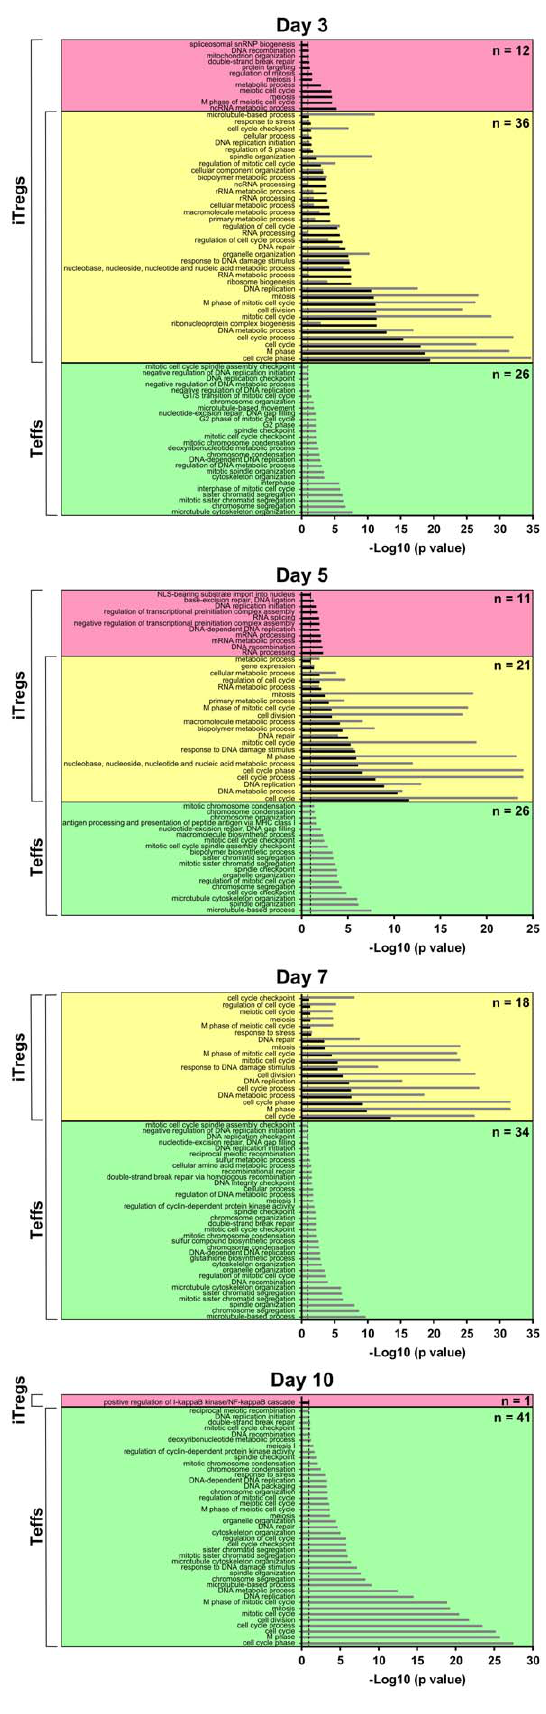
Figure 4. GO term enrichment analysis of biological processes in developing iTregs and Teffs. GO term analysis was performed to identify biological processes significantly over-represented in iTregs and Teffs. Enriched processes in iTregs (black bars) and Teffs (grey bars) at different times organized by their significance score (-log10 p value) are shown. Red and green boxes indicate unique GO terms for iTregs and Teffs, respectively. Yellow boxes represent GO terms enriched in the gene lists of both, iTregs and